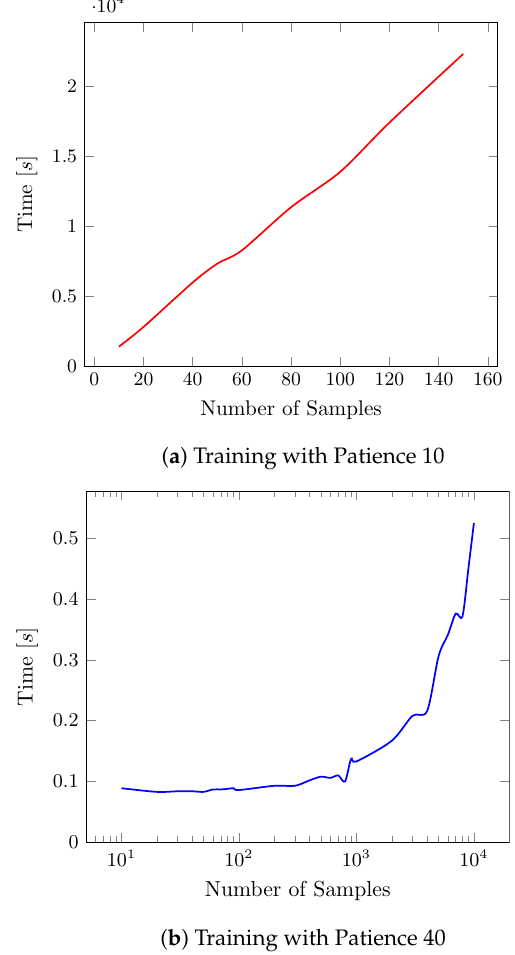
Figure 18. Simulation time according to the number of